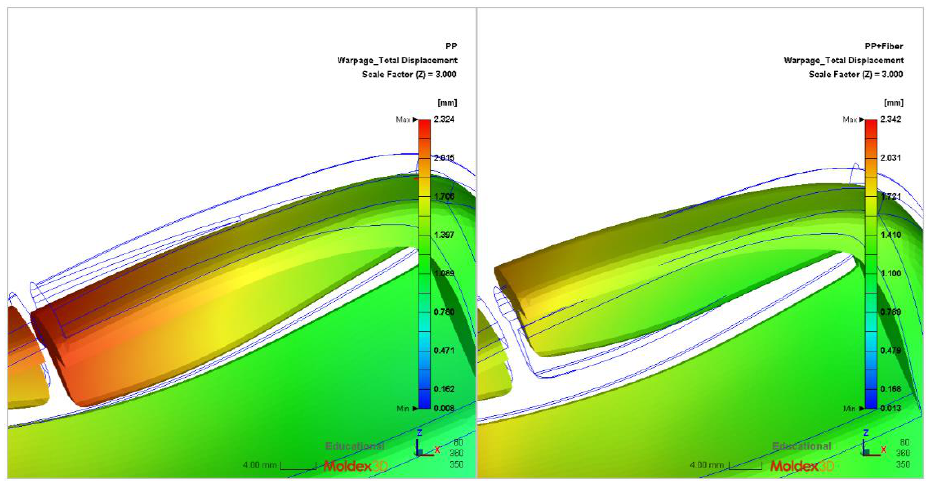
Figure 13. Simulation analysis results of different glass fiber warping orientations at round corners.